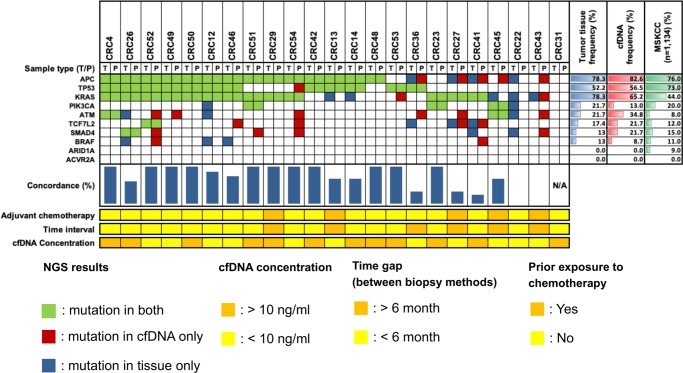
Actionable cfDNA mutations detected by ultra-deep targeted sequencing.Somatic variants are marked in red (cfDNA only), blue (tumor tissue only), and green (both cfDNA and tumor tissue). Population frequencies for each sample type are shown as red (cfDNA) and blue (tumor tissue) gradients. Concordance rates are indicated by vertical blue bars. cfDNA, cell-free DNA; N/A, not applicable; NGS, next-generation sequencing; P, plasma; T, tumor tissue.